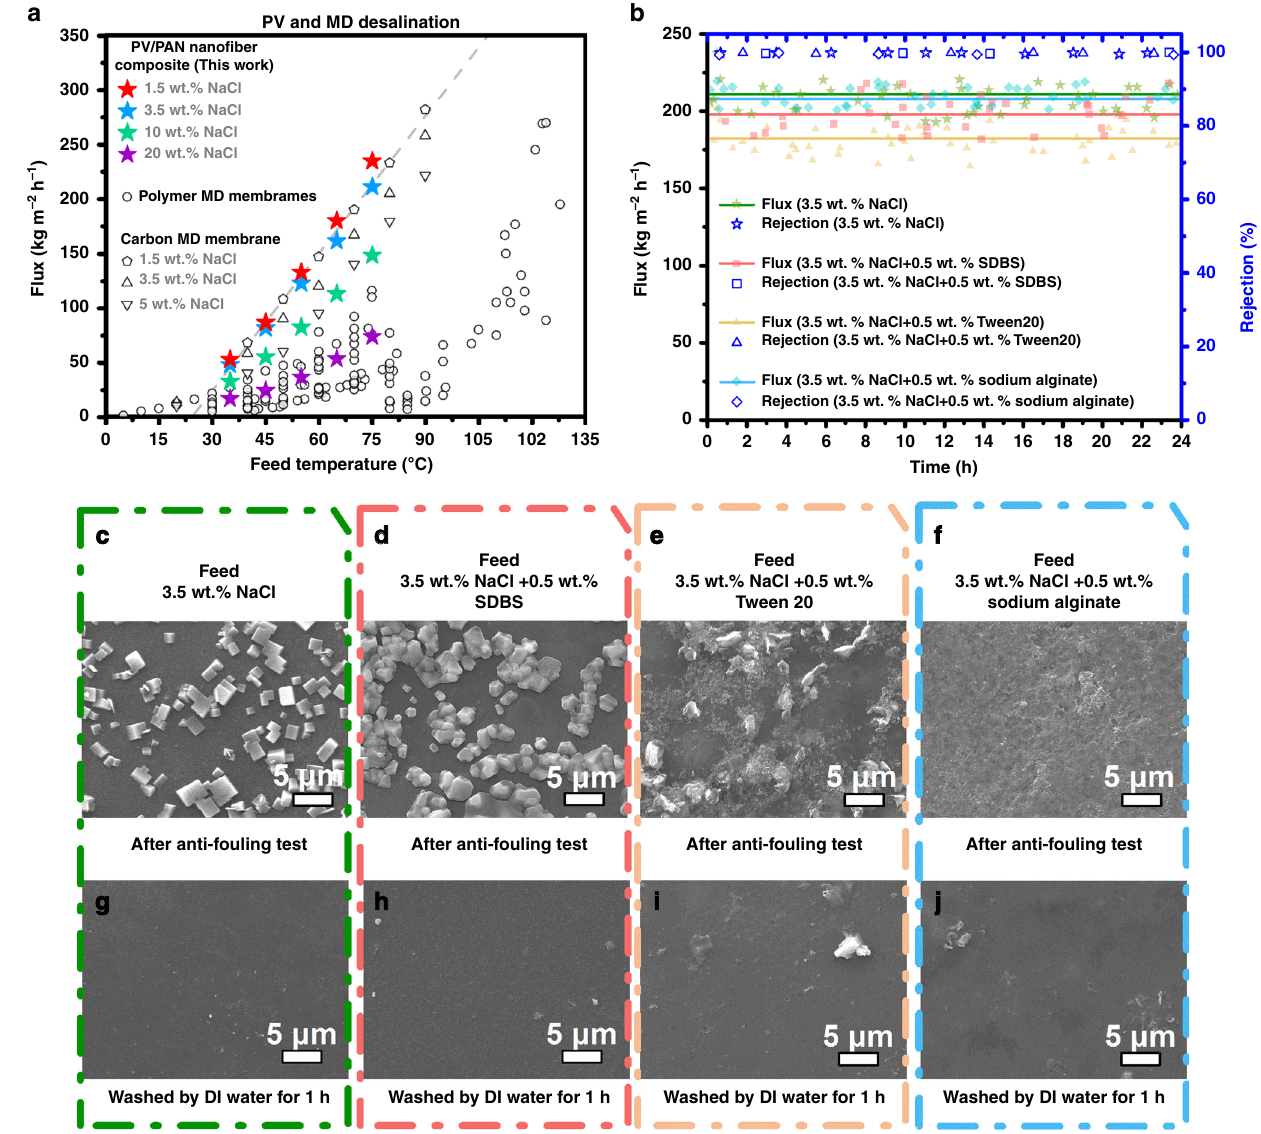
Fig. 4 Desalination properties of brine and polluted salt solutions. a Comparison of the water fl uxes of PVA/PAN nano fi ber composite membranes (in this study) to the reported membrane distillation (MD) data (Supplementary Fig. 42b). b The desalination properties of the PVA/nano fi ber composite membrane